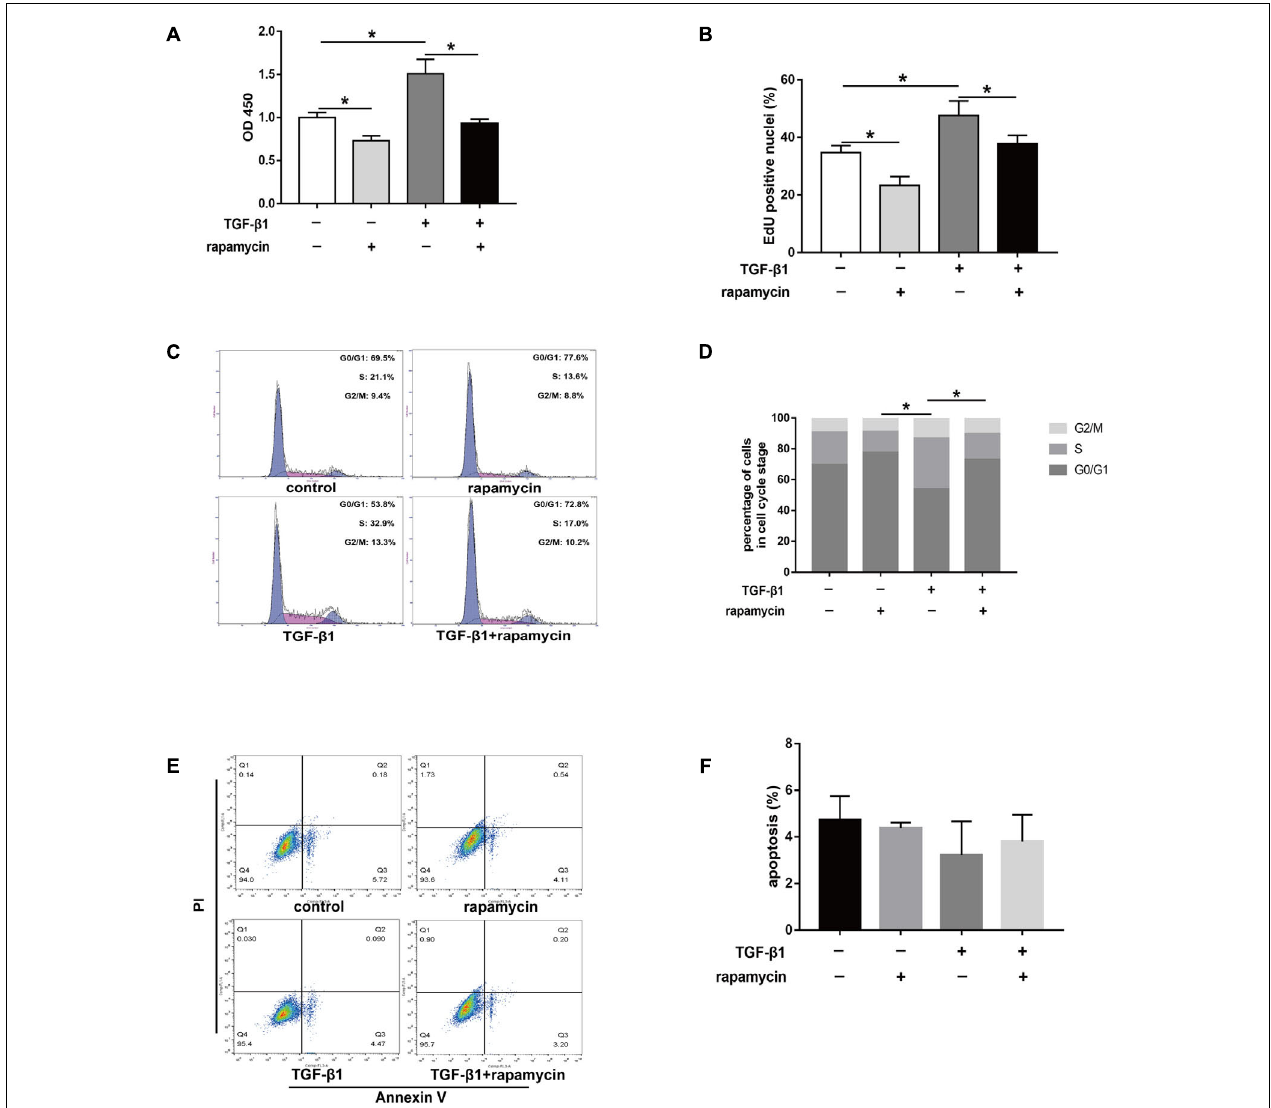
FIGURE 8 | Rapamycin treatment suppresses fibroblast proliferation. (A) CCK8 analysis of cell viability after treated with TGF- β 1 and/or rapamycin for 48 h. (B) Quantitative analysis of proliferative fibroblasts by EdU staining after different treatments for 48 h. (C) Representative images of flow cytometry and (D) quantitative analysis of cell cycle distribution after different treatments for 48 h. (E) Representative images of flow cytometry and (F) quantitative analysis of apoptotic fibroblasts after different treatments for 48 h. Data are shown as the mean ± SD of three independent experiments. ∗ P < 0.05.